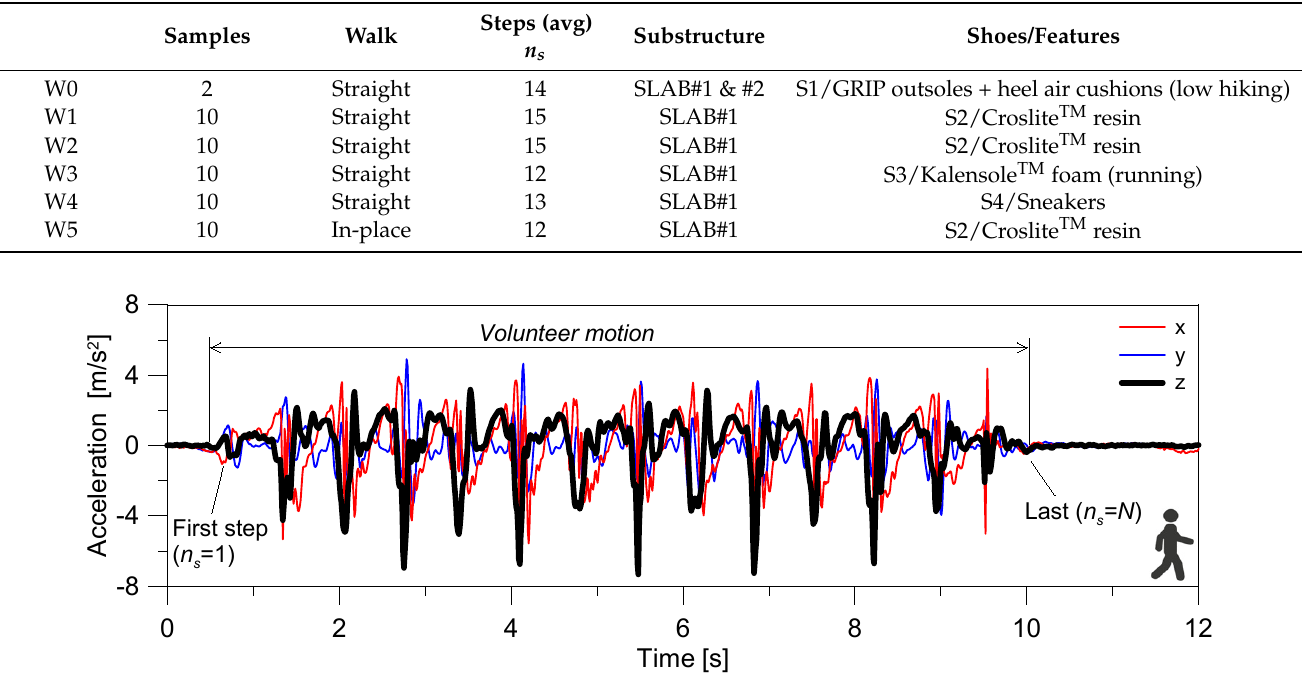
( b ) Figure 4. Reference ( a ) rigid concrete floor (SLAB#1) and ( b ) flexible glass SLAB#2 system for W0 body CoM measures (figure ( b ) adapted from [10] with permission from Elsevier ® , license agree- ment n. 5223670279902, January 2022). 3.2. Derivation of Motion Parameters All the experimental records collected as in Section 3.1 were elaborated to calculate the corresponding walking frequency f s and other relevant motion parameters. The gait length L s was calculated on the basis of covered distance ( L ), divided by the number of steps n s , for each test repetition: 𝐿 (cid:3020) = 𝐿 𝑛 (cid:3046)